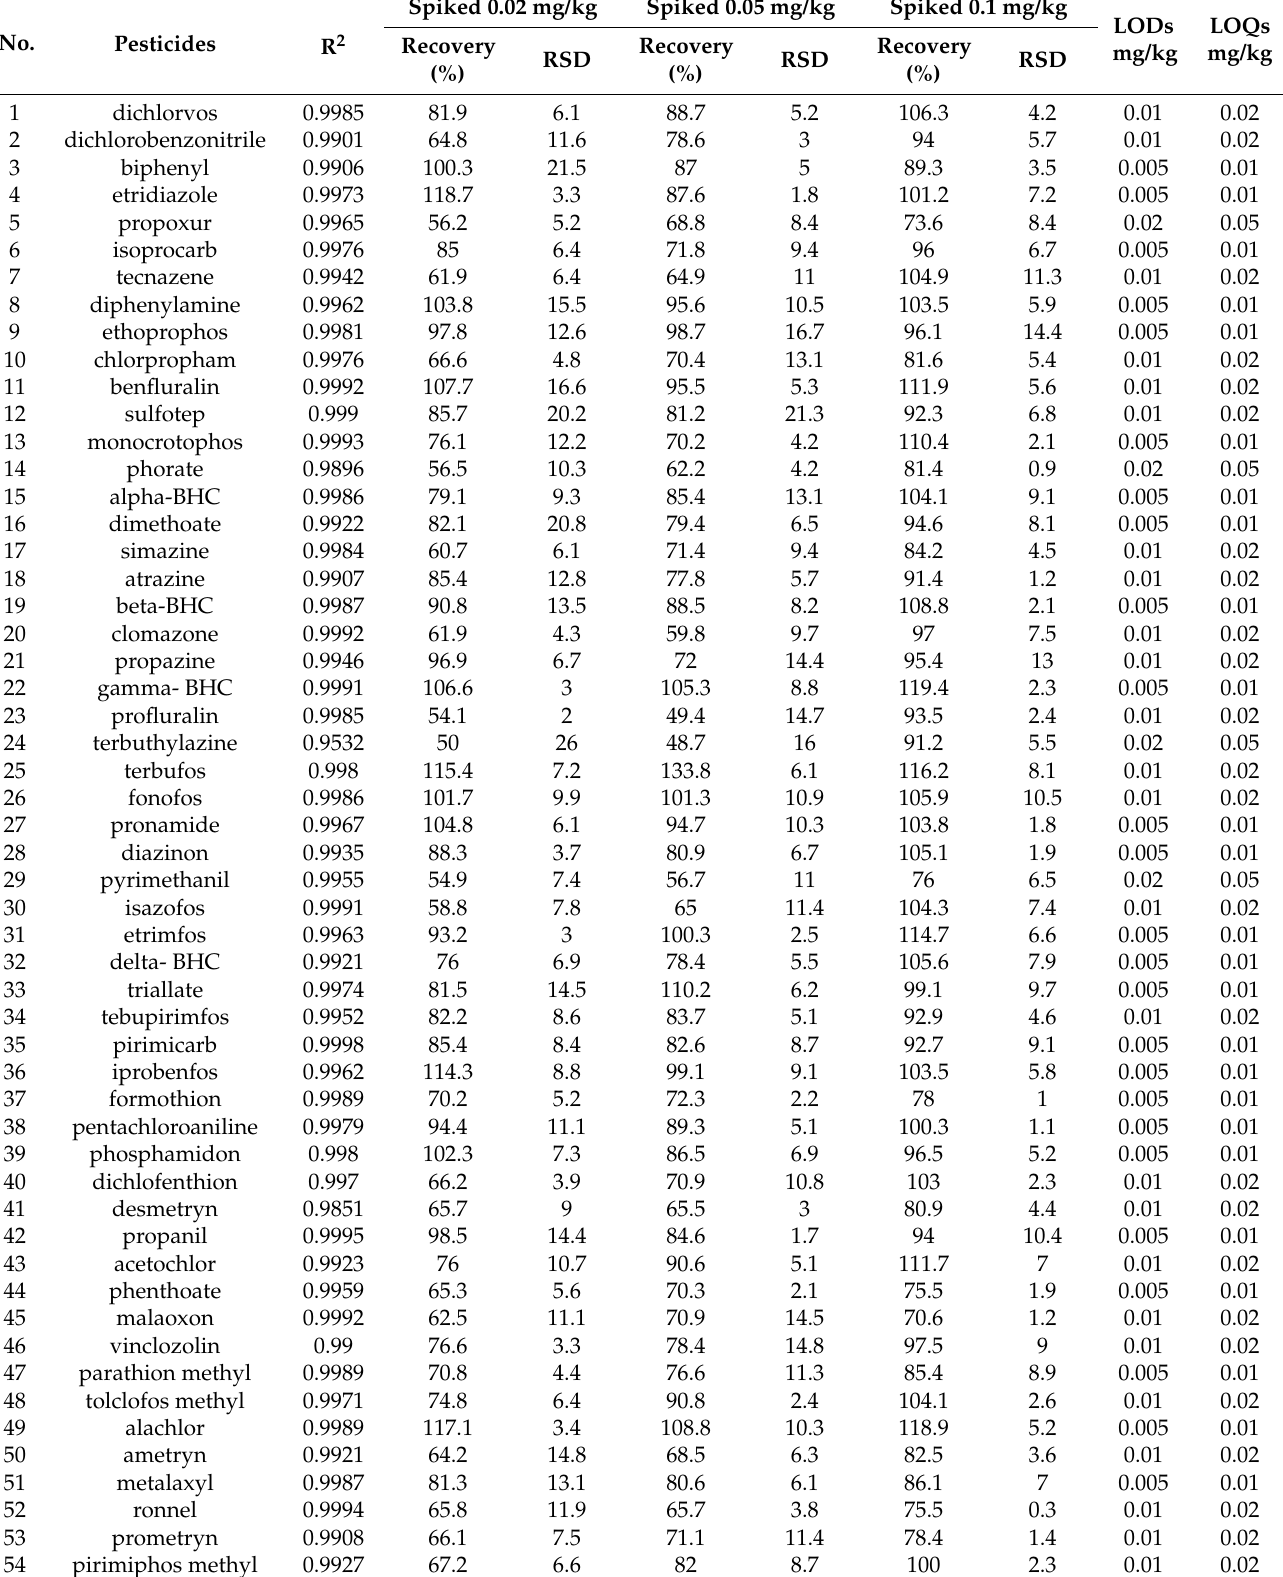
Table 3. Recoveries, relative standard deviations (RSDs), limits of detections (LODs), and limits of quantifications (LOQs) of 186 pesticides using the modified